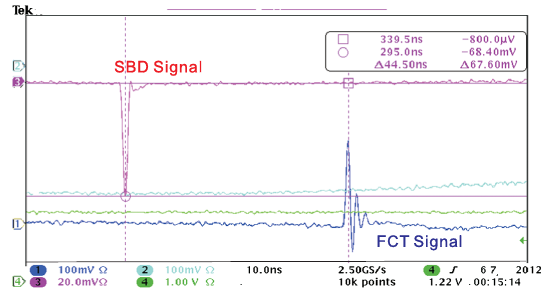
14 (color online). Waveform of SR detected by 0.1 THz SBD (pink) and bunch charge by FCT (blue). The pulse height of SBD waveform was 67.6 mV from about 100 pC = bunch electrons.